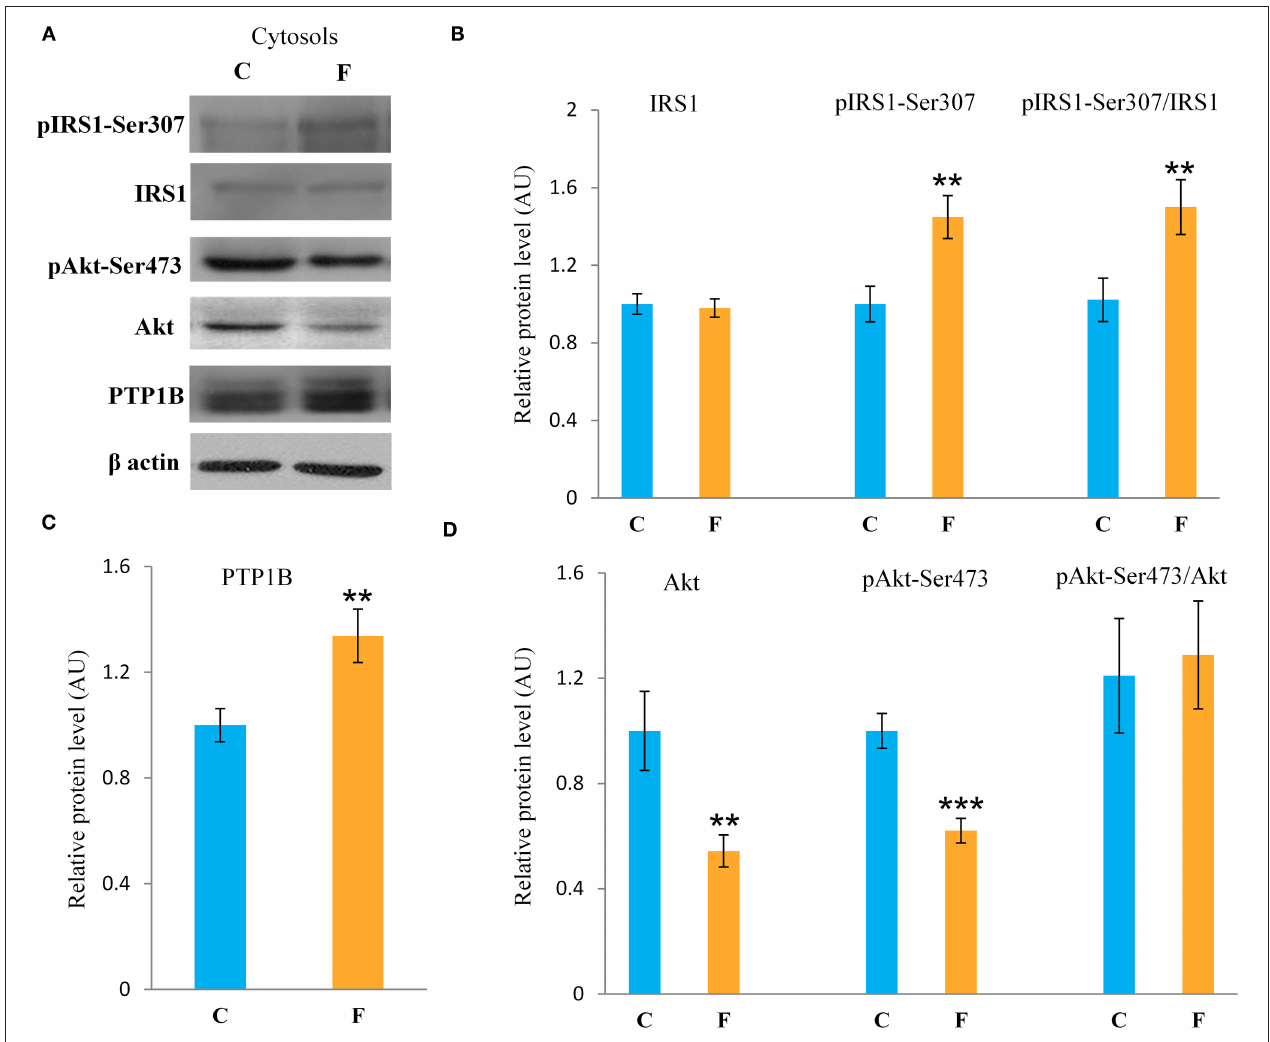
FIGURE 5 | Insulin signaling in the VAT of female rats fed with 10% fructose diet for 9 weeks. Representative (A) Western blots, protein levels of IRS1, pIRS1-Ser307 and its ratio to total IRS1 (B) , protein level of (C) PTP1B, protein levels of Akt, pAKT-Ser473 and its ratio to total Akt (D) . All protein levels were measured by Western blot in the cytosols of the VAT from control (C) and fructose-fed (F) female rats, normalized to β actin and expressed in arbitrary units (AUs). The values represent the mean ± SEM ( n = 8 animals per group). Statistical significance of between-group differences (Student’s t -test): ** P < 0.01 and *** P < 0.001, F vs.